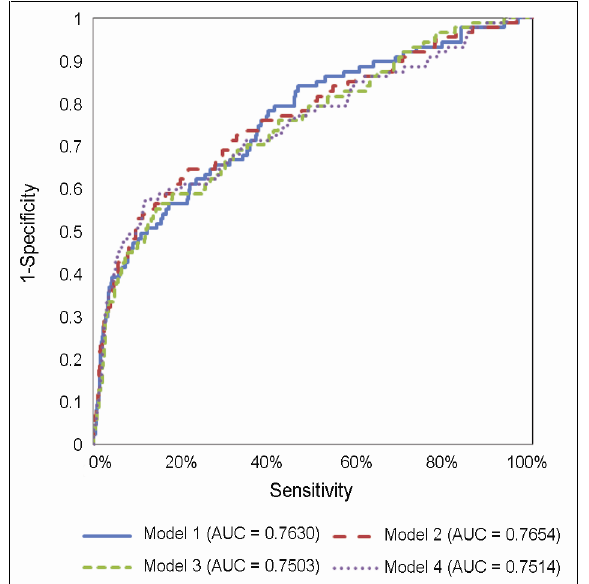
Fig. 3. ROC curves for multivariate Logit models on prior